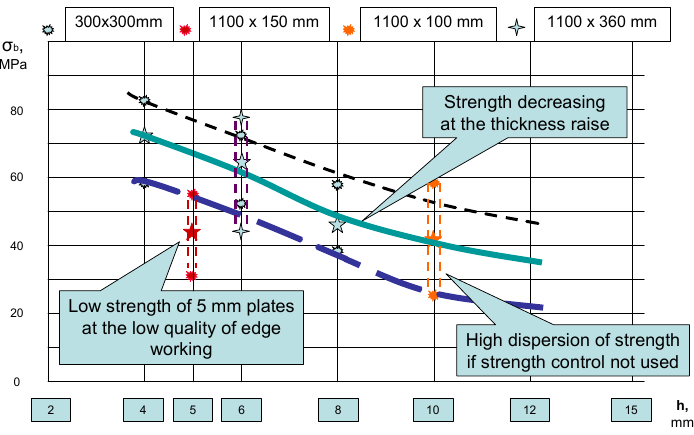
Figure 6. Quality and bending strength σ b of annealed glass subject to thickness of the